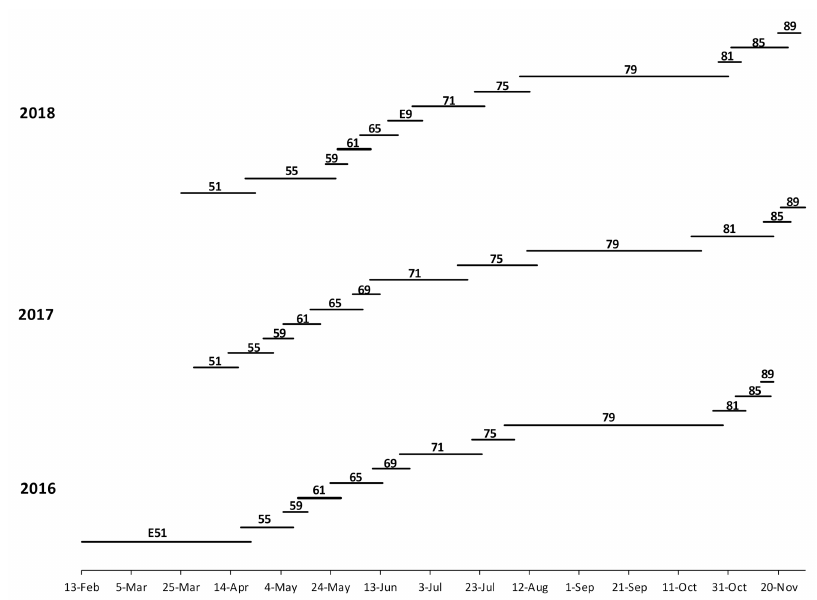
Figure 2. Length of the different phenological phases (Stage 5 phases 51, 55, 59; Stage 6 phases 61, 65, 69; Stage 7 phases 71, 75, 79 and stage 8 phases 81, 85, 89) during the three